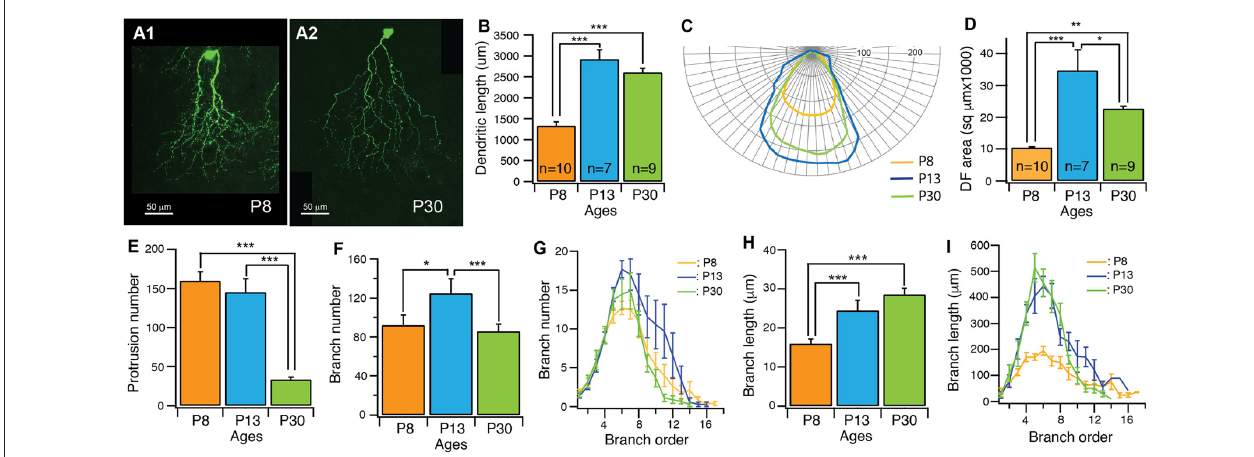
FIGURE 3 | The dendritic pattern of J-RGCs is developmentally refined. The dendritic patterns of J-RGCs were quantitatively analyzed from three groups of JamB-CreER:Thy1-YFP mice at the ages of P8 (3 mice, 10 cells), P13 (2 mice, 7 cells) and P30 (3 mice, 9 cells), respectively. (A) Maximum projections of confocal images of J-RGCs from a P8 mouse (A1) and a P30 mouse (A2) . (B) The average total length of dendrites of J-RGCs of the three age groups. (C) The average polar plots of the dendritic field (DF) of the J-RGCs of three age groups shown in (B) . These average polar plots were calculated by aligning the polar plots of individual J-RGCs based on the soma and the peak of the polar plots. (D) The average size of DF of J-RGCs of three age groups shown in (B) . (E) The average number of dendritic protrusions of J-RGCs of the same three age groups. (F) The average number of dendritic branches of the three groups of J-RGCs. (G) The plot of the average number of dendritic branch as a function of branch order of the three groups of J-RGCs. (H) The average length of dendritic branches of J-RGCs of the three groups. (I) The plot of dendritic branch length as a function of branch order of the three groups of J-RGCs. ∗ P < 0.05; ∗∗ P < 0.01; and ∗∗∗ P <